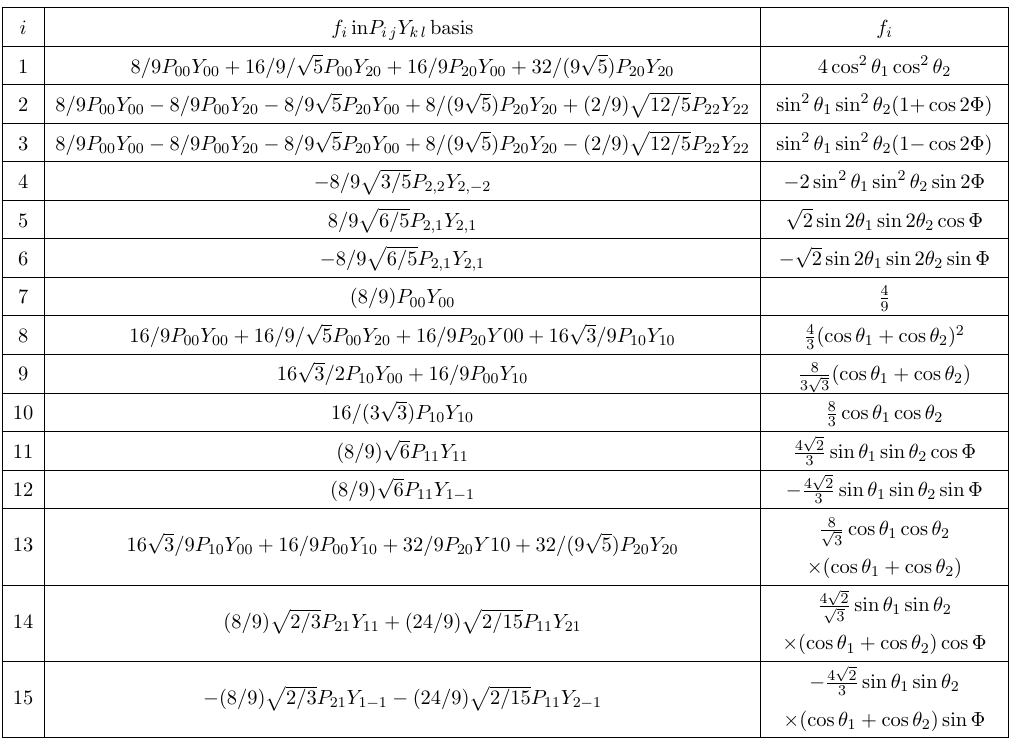
Table 1 . Angular coe(cid:14)cients, written in the same basis as the e(cid:14)ciency